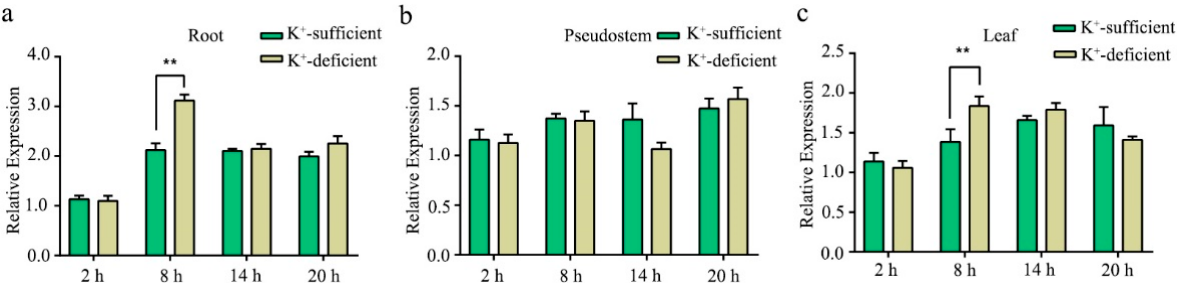
Figure 4. Expression profiles of MaHAK5 in different tissues of banana plantlets and under different potassium conditions. Expression level of MaHAK5 in banana roots ( a ), pseudostems ( b ), and leaves ( c ) under potassium-sufficient conditions (normal Hoagland culture medium) and potassium-deficient conditions (Hoagland culture medium without potassium), at the indicated times. Data are shown as means ± SE (n = 3 parallel samples). Student’s t ‐ test (**, p < 0.01) was used to determine the statistical significance of differences between different potassium conditions.